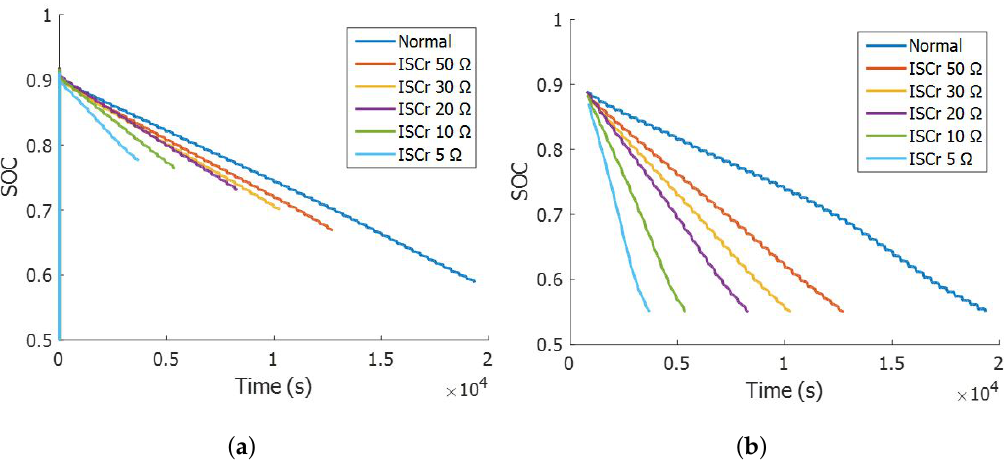
Figure 6. Estimated SOCs with different R ISCr s in experiment with DST current profile: ( a ) battery pack and ( b ) faulted battery